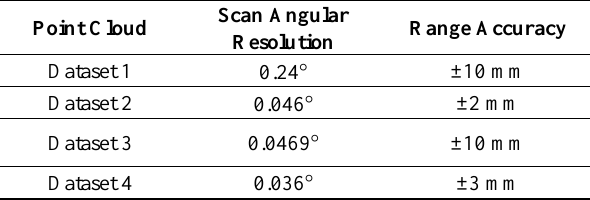
Table 1. Description of the test point clouds.